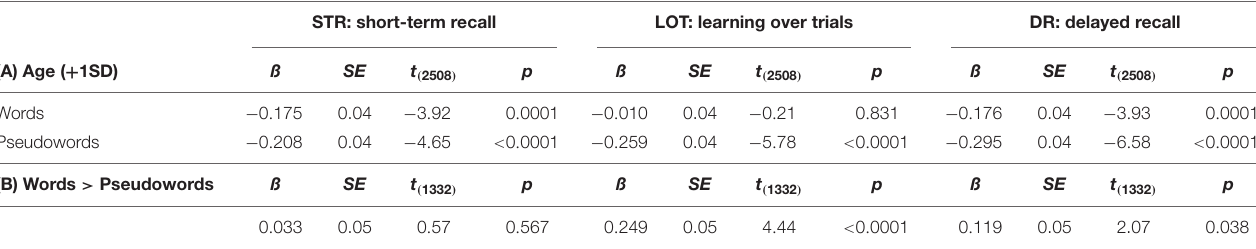
TABLE 3 | Memory performance as a function of age for words and pseudowords at each memory stage after adjusting for sex, education, vocabulary scope, rhyming, WMC, and handedness. STR: short-term recall LOT: learning over trials DR: delayed